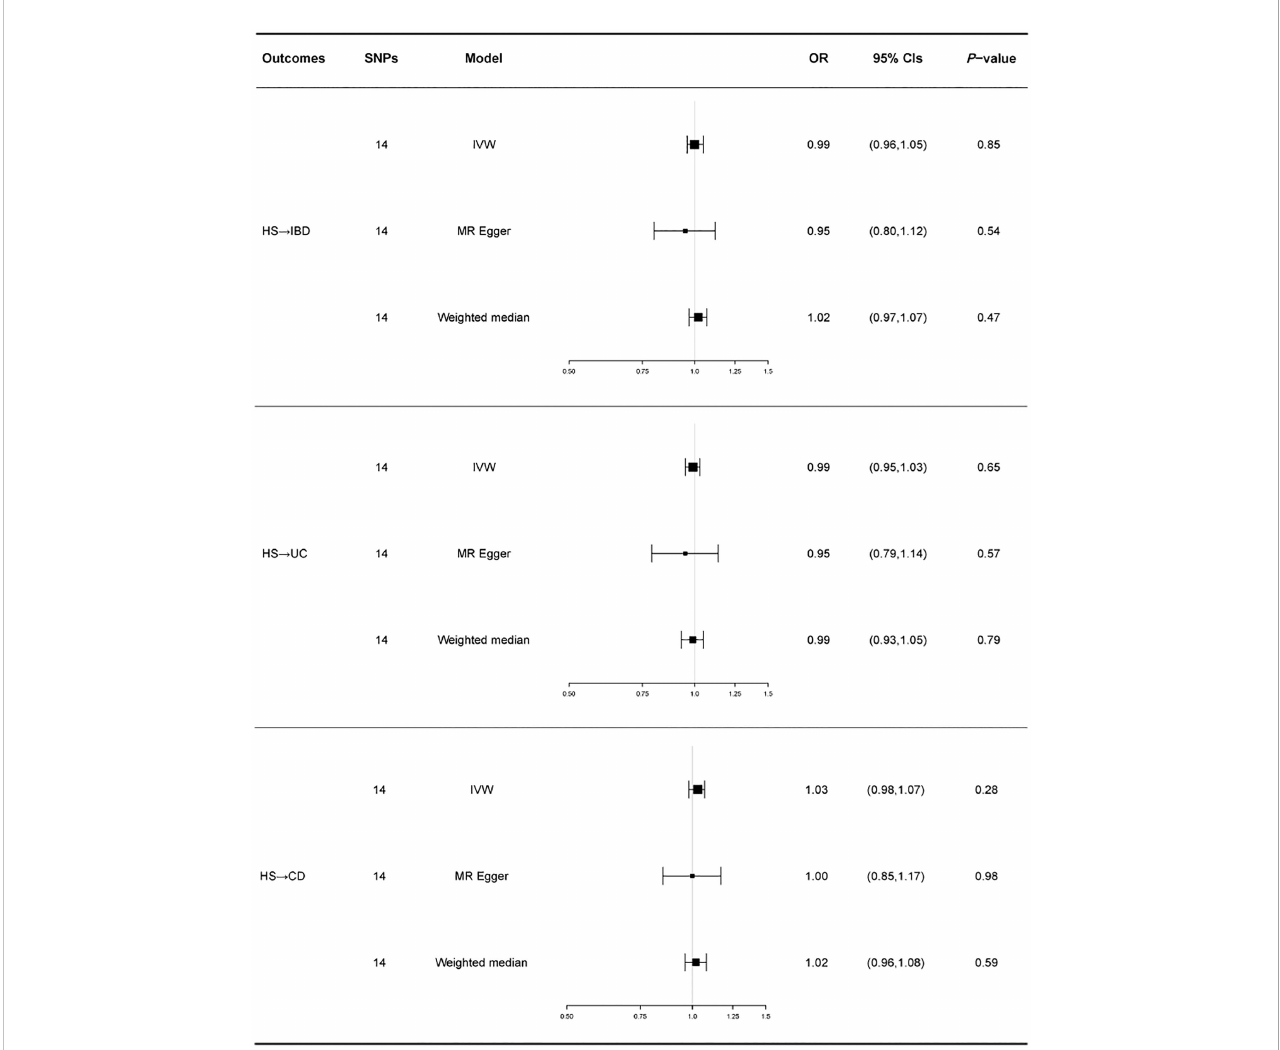
FIGURE 4 For the effect of hidradenitis suppurativa on in fl ammatory bowel disease, ulcerative colitis and Crohn ’ s disease, causal estimates are given as odds ratio (OR) and 95% con fi dence interval (CI). IBD, in fl ammatory bowel disease; UC, ulcerative colitis; CD, Crohn ’ s disease; HS, hidradenitis